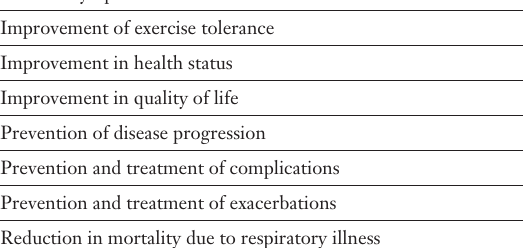
Objectives of man- agement for